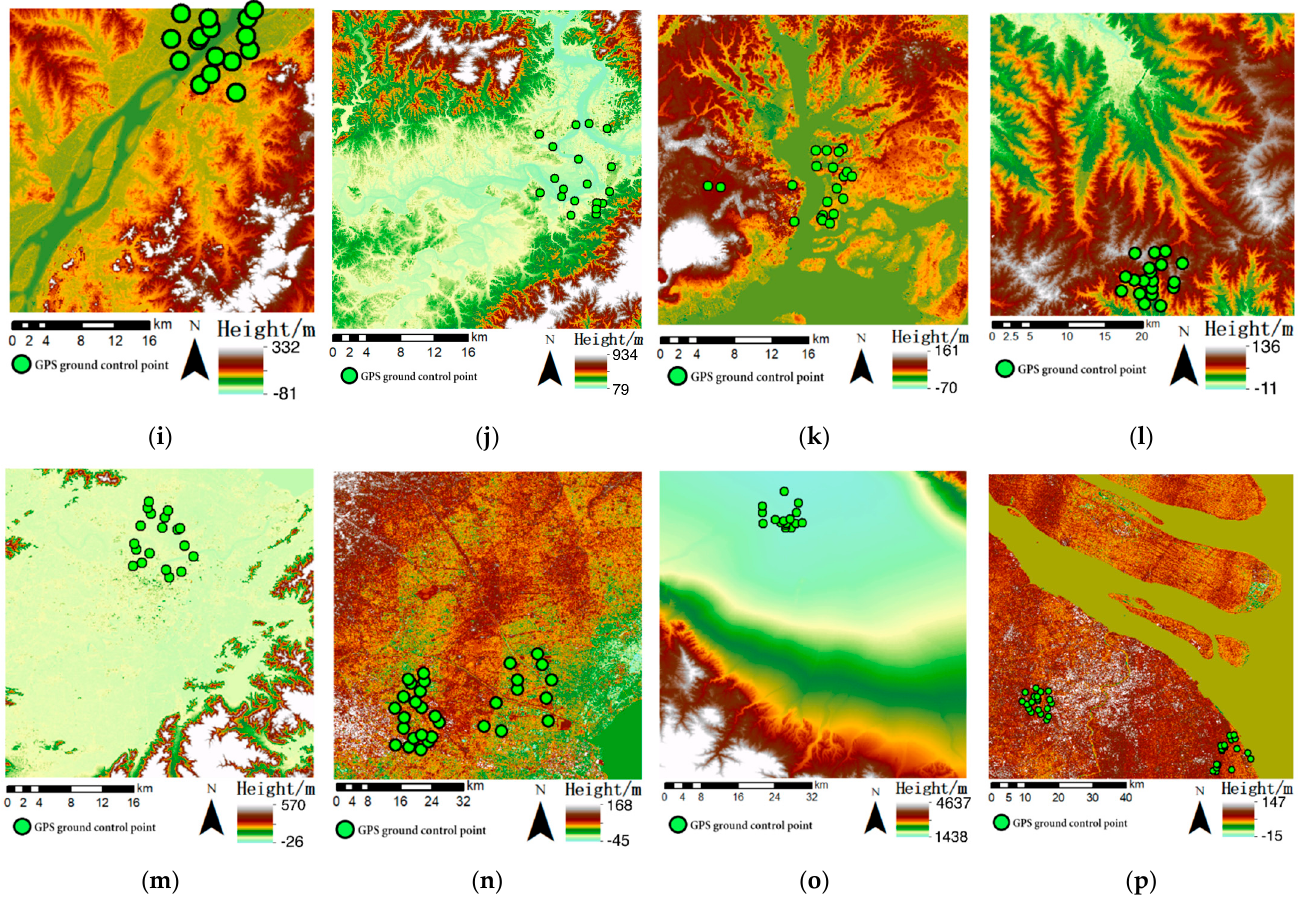
Figure 3. Images showing topographies of the sixteen study areas in China (generated by AW3D30DEM): ( a ) Fangshan, ( b ) Yantai 1, ( c ) Yantai 2, ( d ) Zhengzhou, ( e ) Hefei, ( f ) Chengdu, ( g ) Wenchang, ( h ) Wuhan, ( i ) Nanjing, ( j ) Ganzhou, ( k ) Zhanjiang, ( l ) Weinan, ( m ) Ningbo, ( n ) Beichen, ( o ) Zhangye, and ( p ) Pudong.